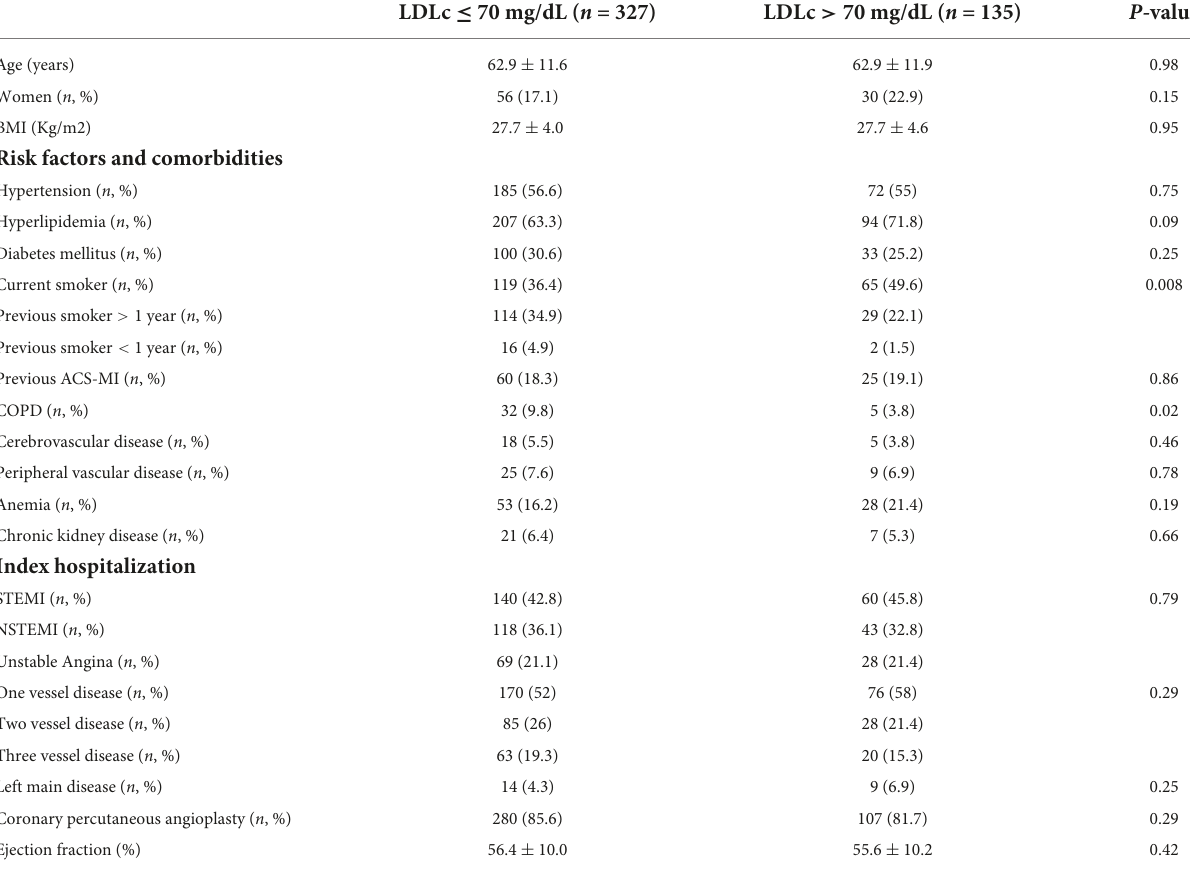
TABLE 1 Baseline characteristics of patients according to LDLc levels after the optimization